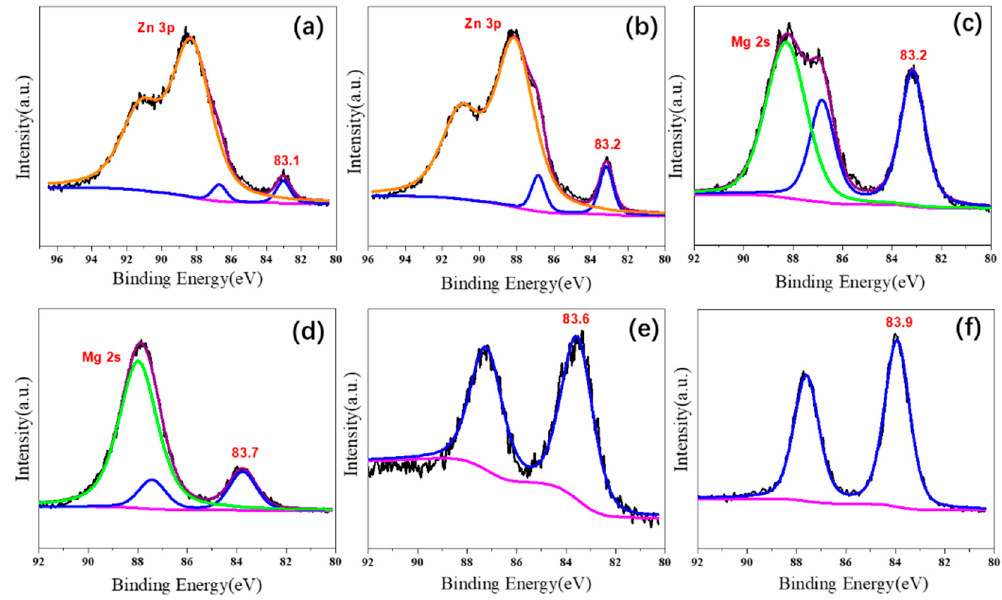
Figure 5. X-ray photoelectron spectra of Au 4f on different supported gold catalysts; ( a ) Au 25 /ZnAl-300; ( b ) Au 25 /ZnO-300; ( c ) Au 25 /MgAl-300; ( d ) Au 25 /MgO-300; ( e ) Au 25 /Al 2 O 3 -300; ( f ) Au 25 /SiO 2 -300.